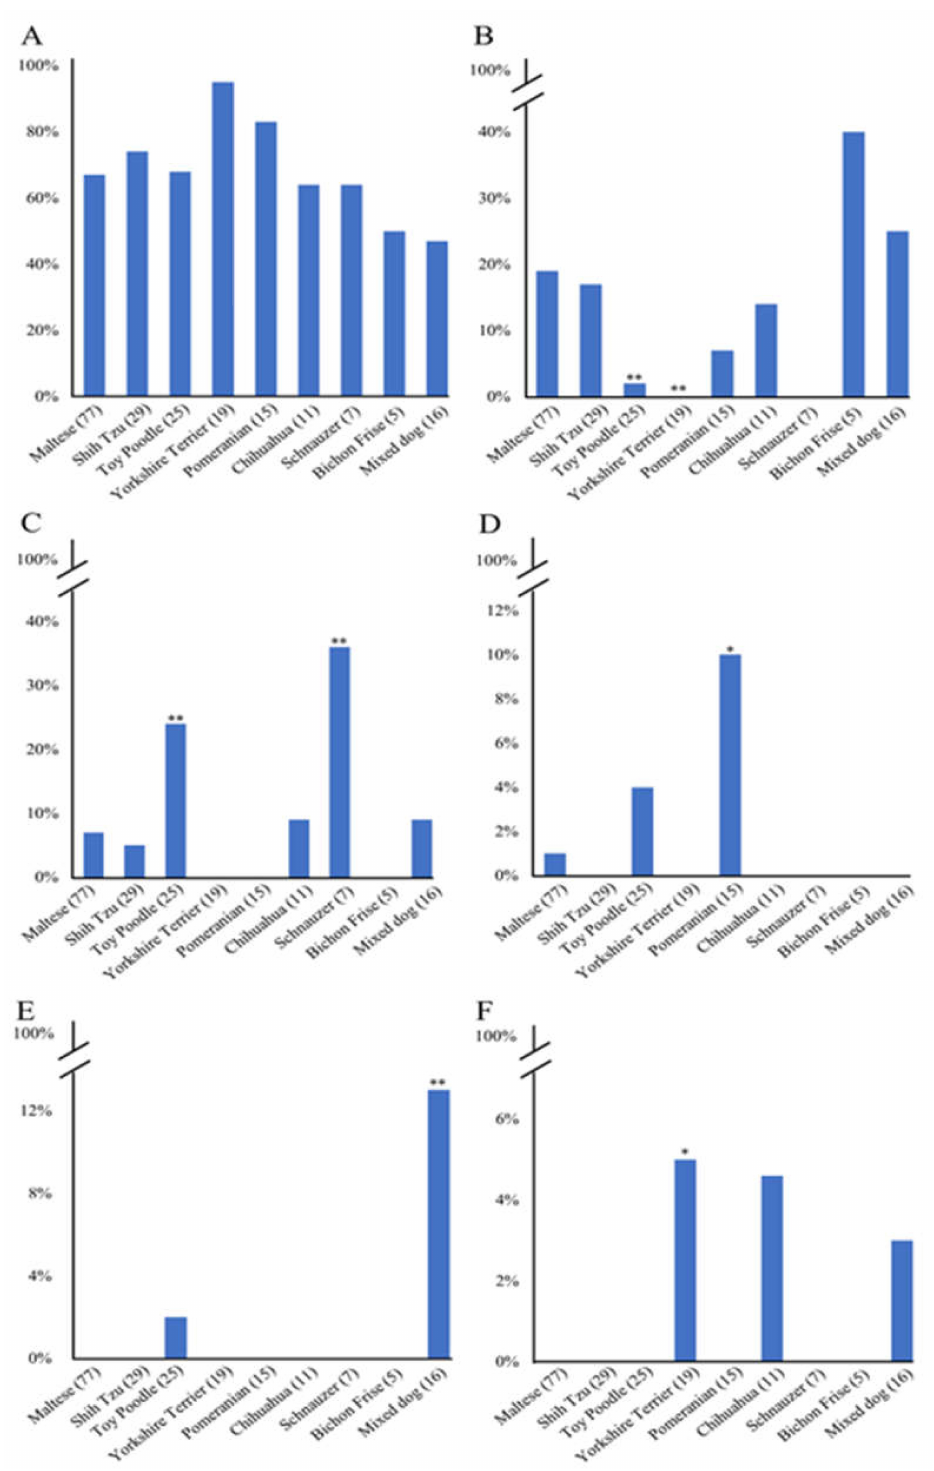
Figure 5. Comparison of the distribution of haplotypes according to dog breeds. ( A ) Comparison of the distribution of haplotype 1 among 8 dog breeds. ( B ) Comparison of the distribution of haplotype 2 between Maltese and other breeds. ( C ) Comparison of the distribution of haplotype 3 between Maltese and other breeds. ( D ) Comparison of the distribution of haplotype 4 between Maltese and other breeds. ( E ) Comparison of the distribution of haplotype 5 between Maltese and other breeds. ( F ) Comparison of the distribution of haplotype 6 between Maltese and other breeds. Parentheses indicate each number of dog breeds. * indicates p < 0.05. ** indicates p <